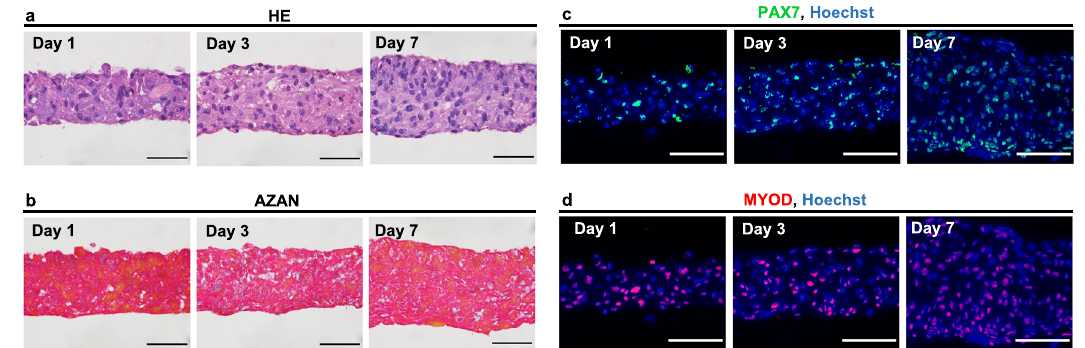
Fig. 3 Histological analysis of a bovine myoblast cell sheet. a HE-stained sections of bovine myoblast cell sheets. b AZAN-stained sections of bovine myoblast cell sheets. c PAX7 and d , MYOD staining of the bovine myoblast cell sheets. Left: day 1 of culture, center: day 3 of culture, right: day 7 of culture. Scale bar: 1 cm.